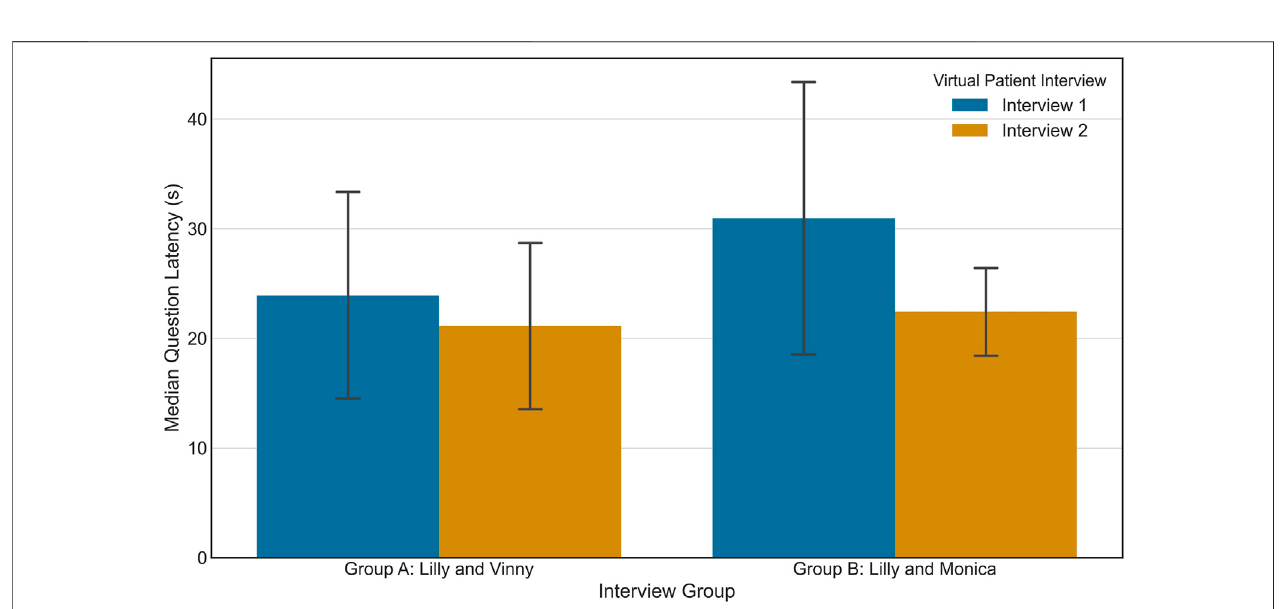
FIGURE 5 | The means and standard deviations of median question latency for students in the Message Production Trends study.